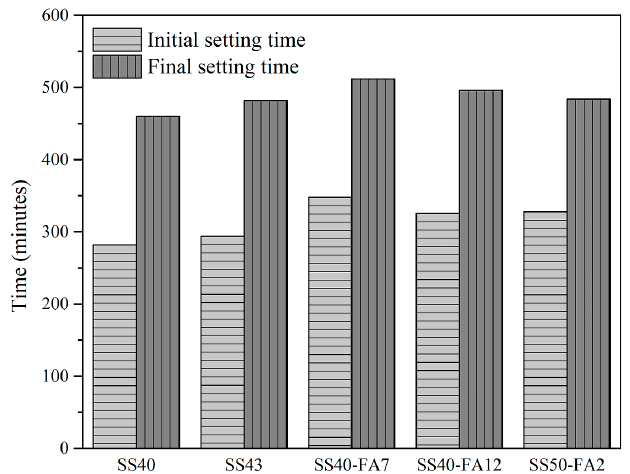
Figure 5. Initial and fi nal se tt ing times of SS-based composite cementitious materials.